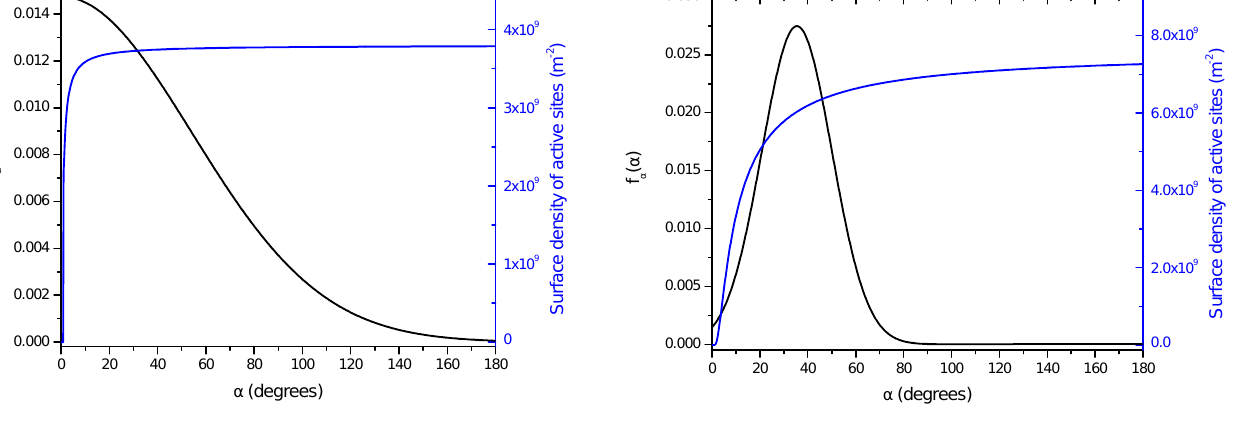
Fig. 8. Probability distribution function for the PDF- α model and surface density of active sites, ρ(α) , for the active site model. Shown are the results for illite particles.